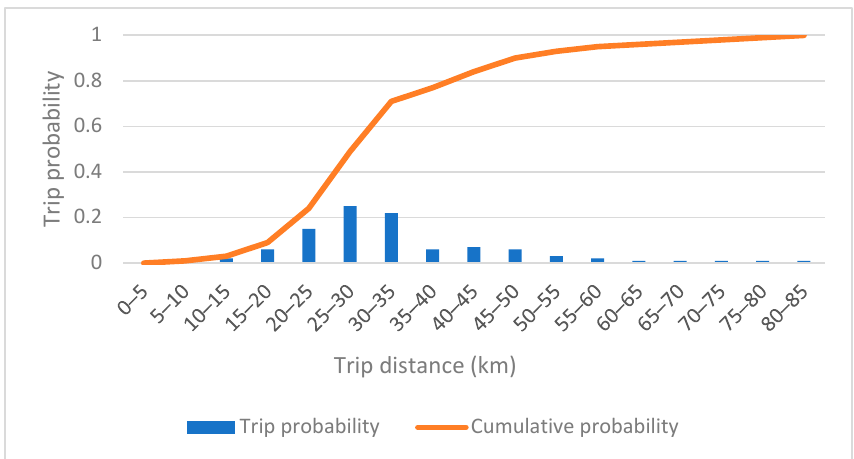
Figure 8. Tourist trip probability and its relation to trip distance.